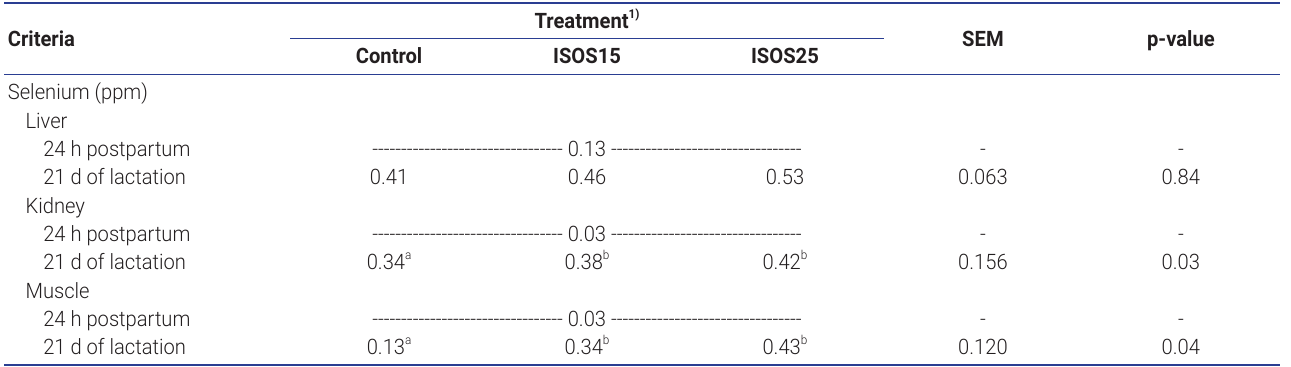
Table 6. Effects of supplemental selenium in the lactation diet on the tissue selenium concentration in piglets